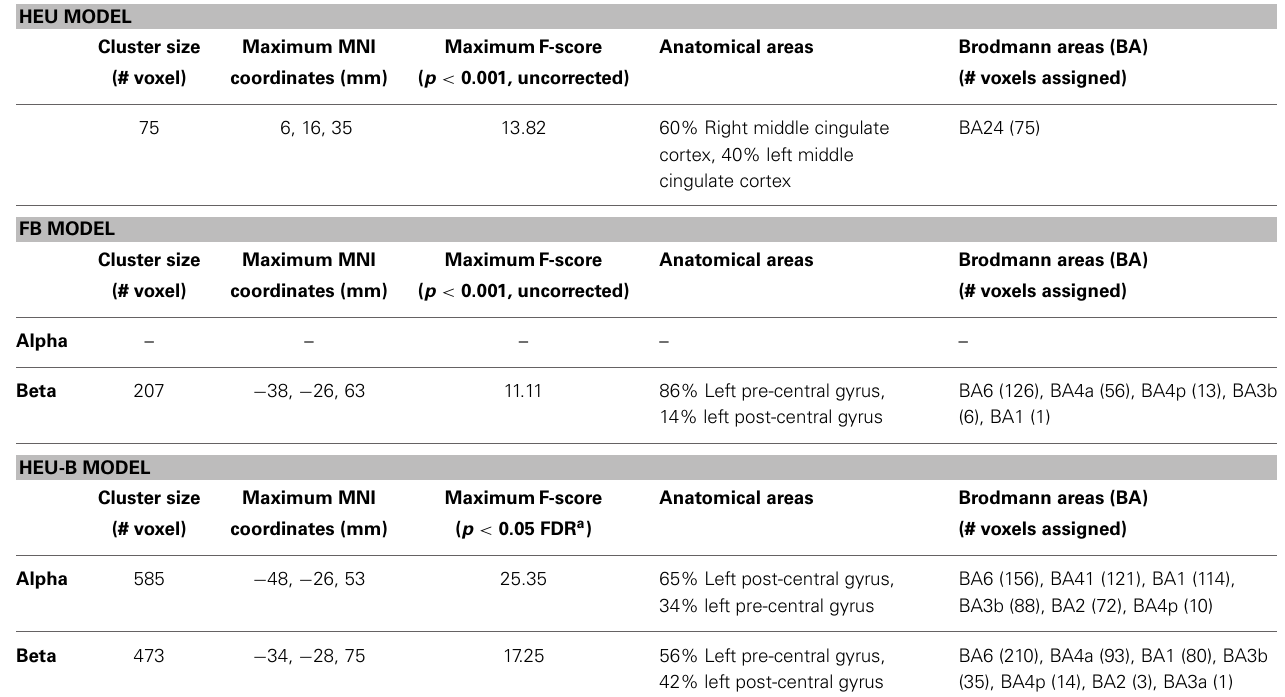
Table 2 | Single model